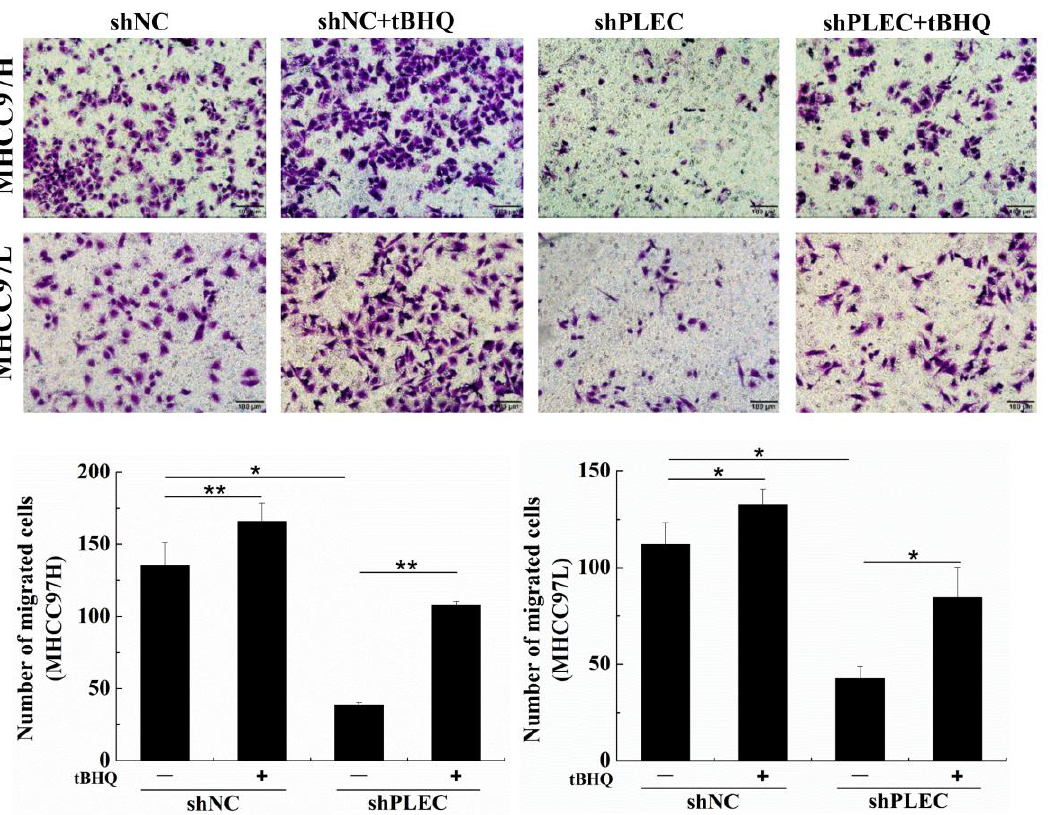
Figure 4. Activation of ERK1/2 recovered the plectin downregulation-inhibited migration of HCC cells. Transwell assays for migration ability evaluation and quantification data of migrated number after tBHQ treatment in cells transfected with shNC and shPLEC (scale bar, 100 μm). tBHQ: tert- butylhydroquinone. Data are presented as mean with SD; n = 3, * p < 0.05; ** p < 0.01.